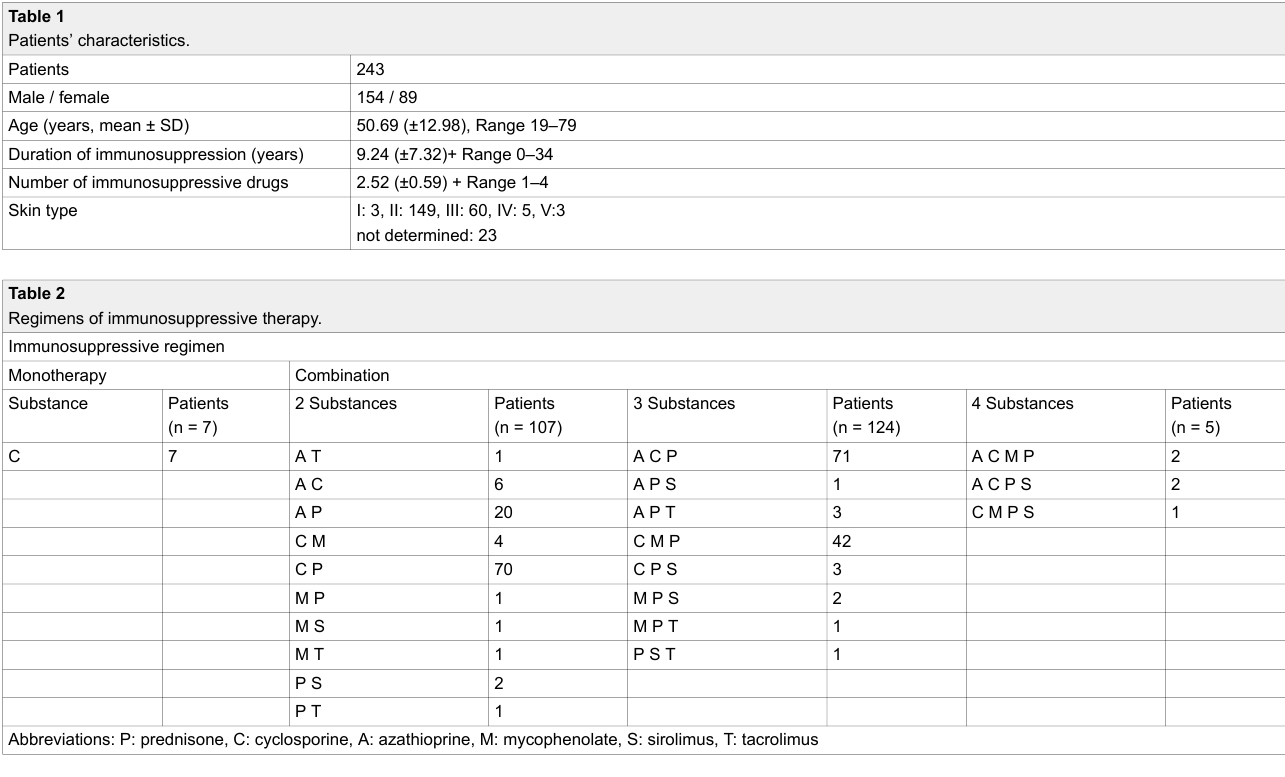
Table 1 Patients’ characteristics.